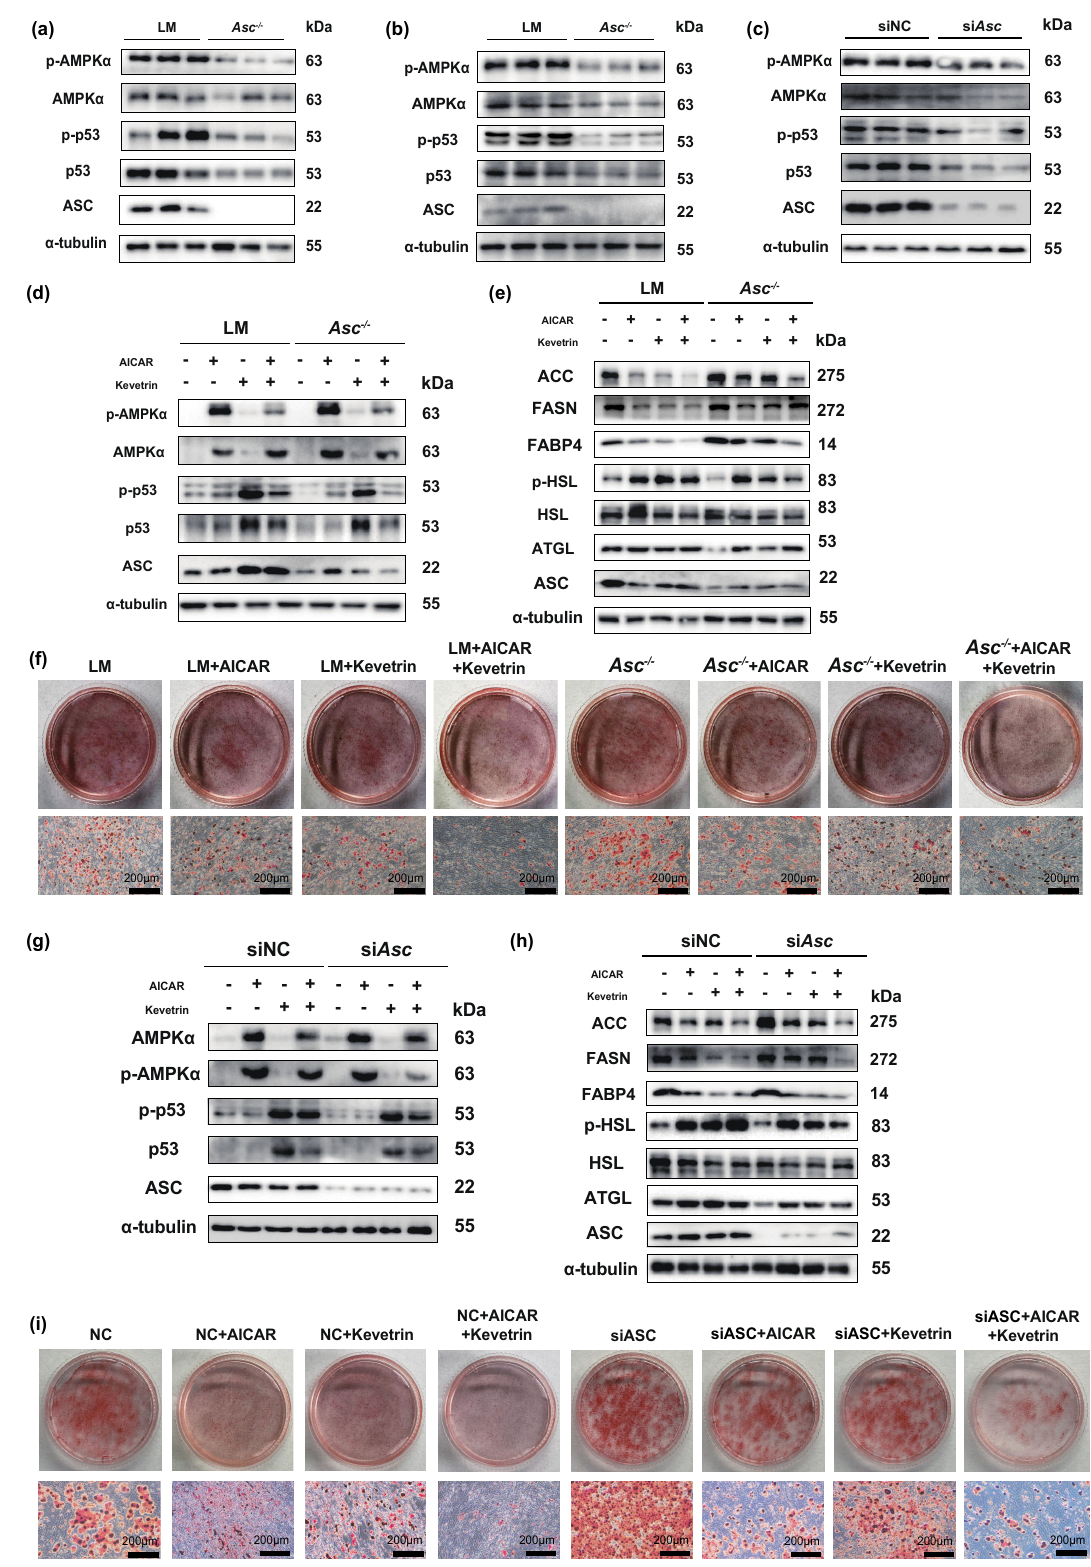
Figure 4. ASC defection promoted lipid accumulation through p53/AMPK α axis. ( a ) Protein expression of phosphor-p53, p53, phosphor-AMPK α , and AMPK α in SAT of LM and Asc − / − mice fed with HFD (12 weeks). ( b ) Protein expression of phosphor-p53, p53, phosphor-AMPK α , and AMPK α in primary SVF cells separated from SAT of LM and Asc − / − mice (n = 3 per